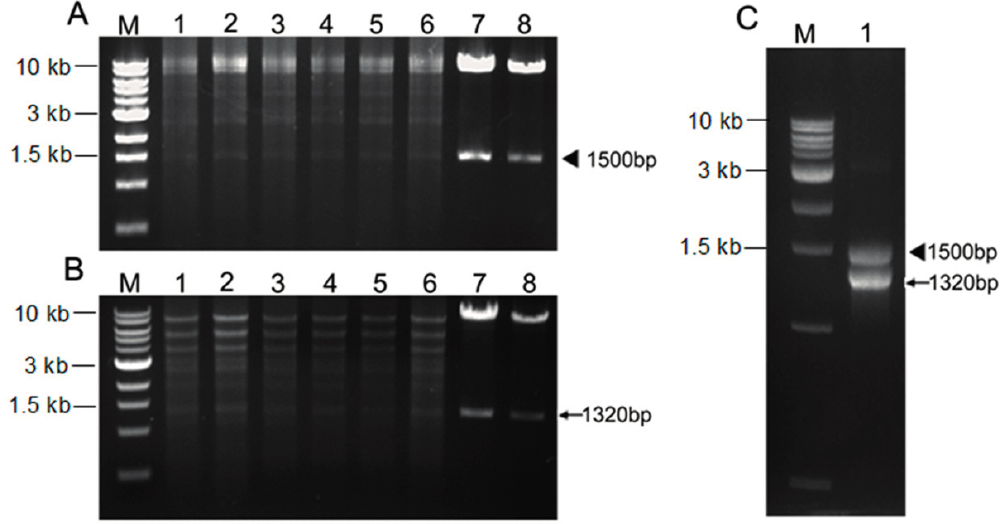
Figure 2. Double-restriction enzyme digestion and PCR analysis of pLEM4159-cel/phy transformants. ( A ) pLEM4159-cel/phy plasmid from L. reuteri XC1 or E. coli DH5 α were double-digested with Spe I and Xba I; ( B ) pLEM4159-cel/phy plasmid from L. reuteri XC1 or E. coli DH5 α were double-digested with Not I and Sac II; and ( C ) PCR confirmation of cel15 and phyAM in L. reuteri pLEM4159-cel/phy using primer pairs P1/P2 and C1/C2. Lane M , 1 kb DNA ladder; Lanes 1 – 6 , L. reuteri pLEM4159-cel/phy; and Lanes 7 – 8 , pLEM4159-cel/phy plasmid from E. coli DH5 α